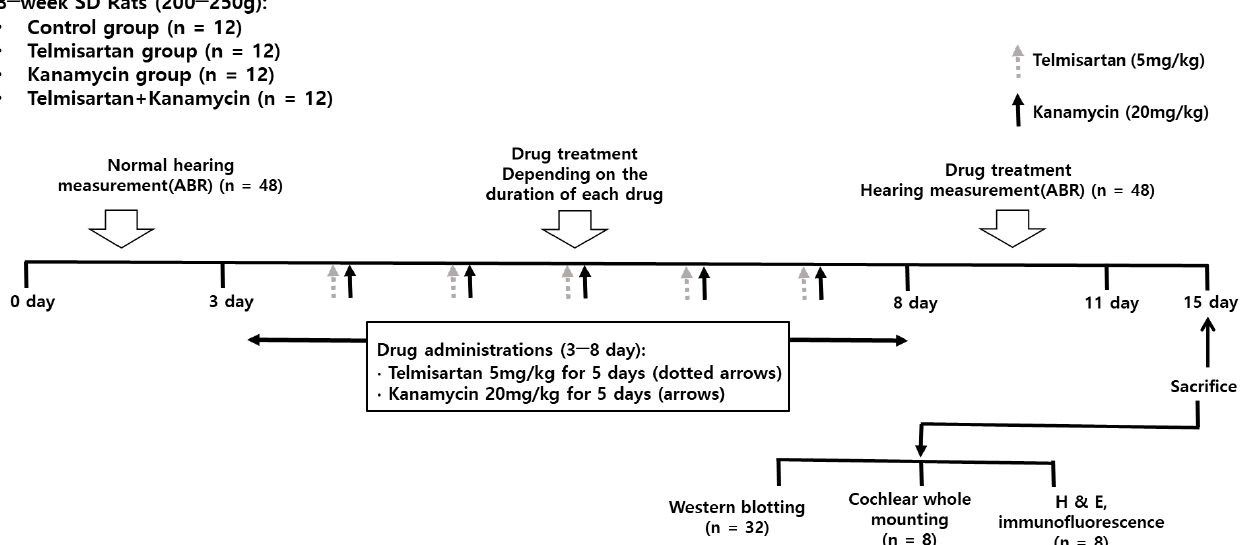
Figure 5. Experimental design of the present study. There were four groups of the control, telmisartan, kanamycin, and telmisartan + kanamycin groups. Hearing levels were measured before and after drug administration.